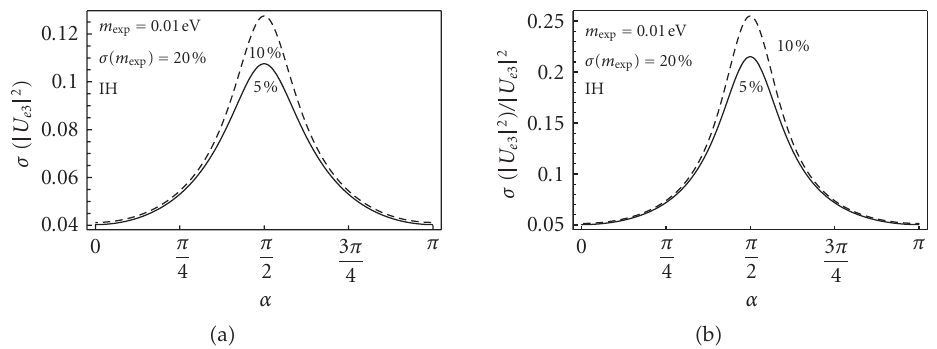
Figure 6: The absolute and relative error on | U e 3 | 2 in case of an inverted hierarchy for negligible m 3 | U e 3 | 2 . Δ m 2 2 θ A and sin 12 are both given a relative error of 5 and 10% respectively. The strong dependence on clearly visible from the